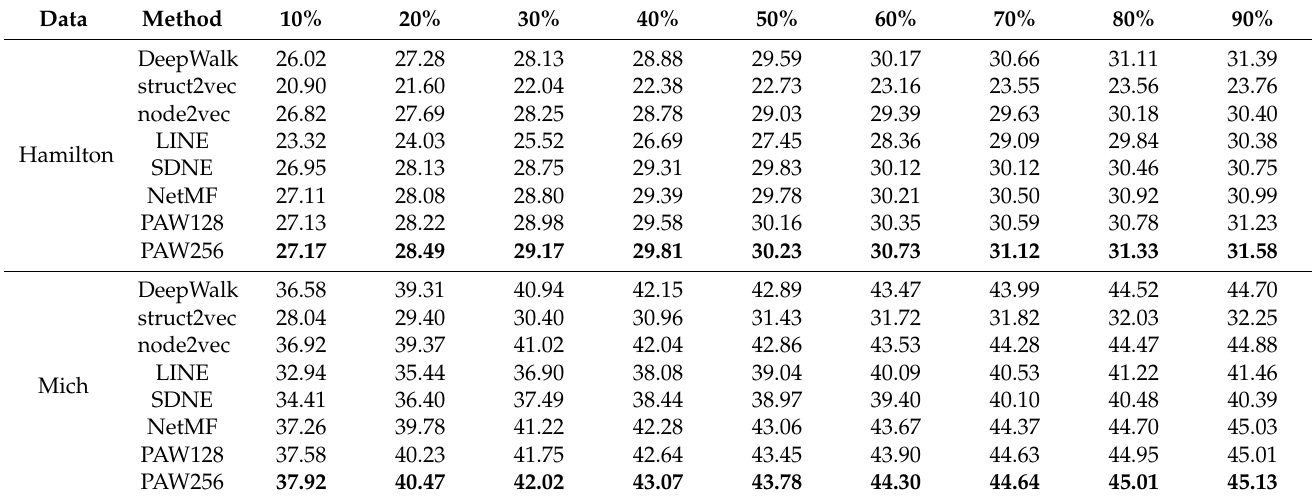
Table 3. Results of single-label classification using the Micro-F1 evaluation (%) on the Hamilton and the Mich datasets. Data Method